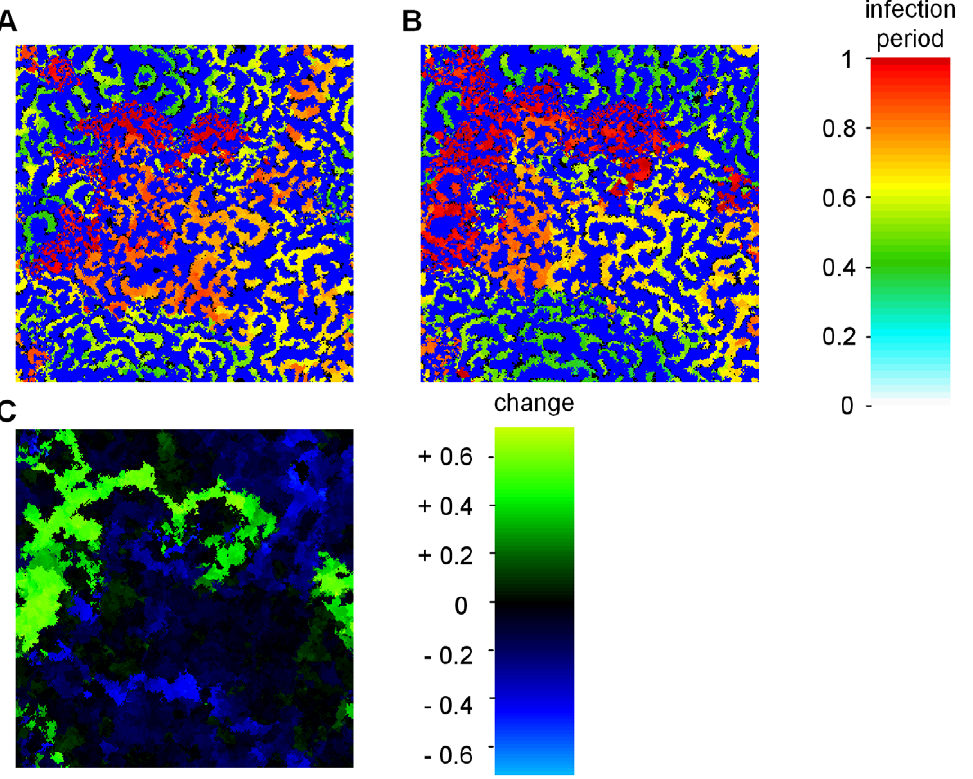
Figure 3. Spatial distribution in the cyclic evolutionary attractor. A: Spatial pattern of length of infection period after 380 time units. B: Spatial pattern after 400 time units; C: Difference in infection period between A and B. Depending on the local pattern, the infection period evolves up or down. Field size is 300 6 300 with periodic boundary conditions; mutation rate is m =0.05, with D t i =0.01. Other parameters and settings are as in Fig. 1. For a movie see supporting Video S4.